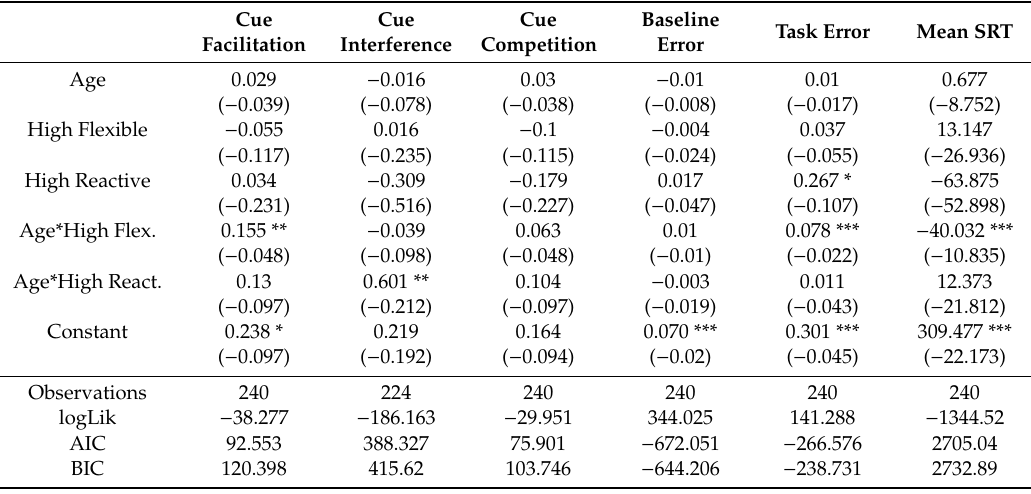
Table 3. Linear mixed e ff ects (LME) and conditional growth curve analysis for the high flexible and high reactive profiles compared to the low reactive